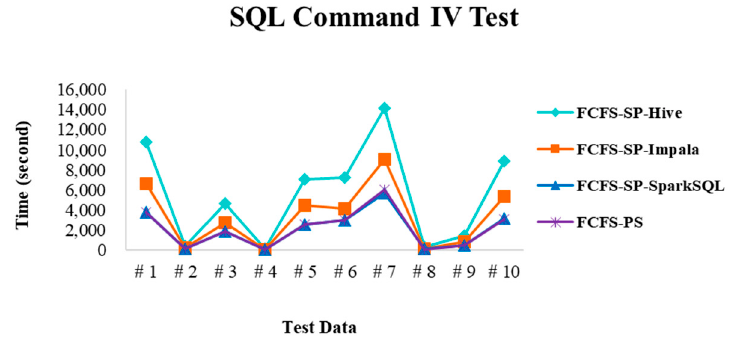
Figure 28. Execution time of SQL command IV in test environment III.